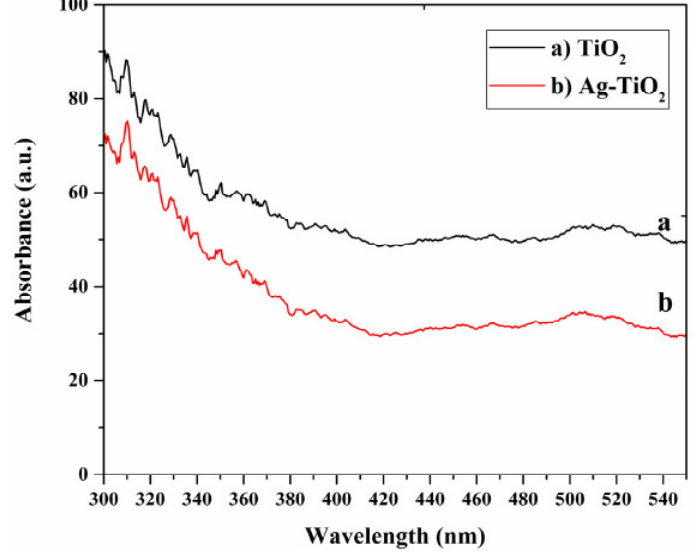
Fig. 6. Diffuse Reflectance Spectra (DRS) of TiO